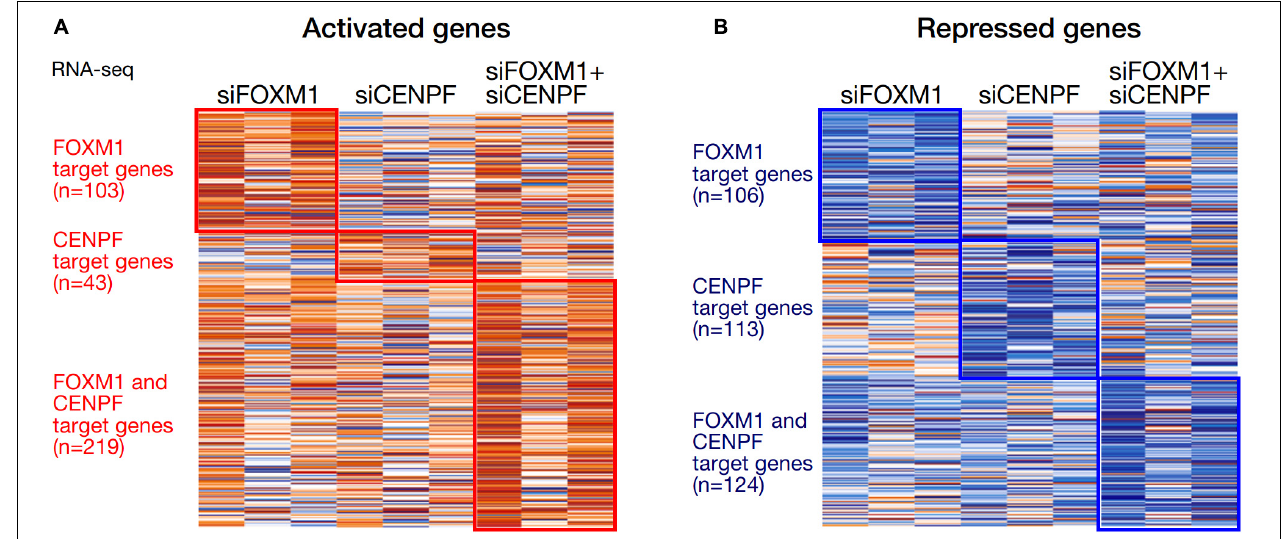
FIGURE 3 | Heatmaps of the differentially expressed genes in HCC cells with knockdown of FOXM1 and CENPF. (A) Orange color indicates genes that were activated upon silencing of FOXM1 and/or CENPF. 103 genes were upregulated upon FOXM1 knockdown. About 43 genes were upregulated upon CENPF knockdown. 219 genes were upregulated upon FOXM1 and CENPF co-knockdown. (B) Blue color indicates genes that were repressed upon silencing of FOXM1 and/or CENPF. About 106 genes were downregulated upon FOXM1 knockdown. 113 genes were downregulated upon CENPF knockdown. About 124 genes were downregulated upon FOXM1 and CENPF